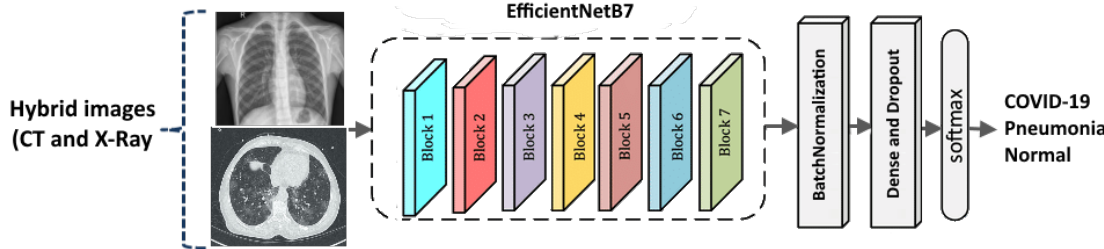
Figure 4. The proposed